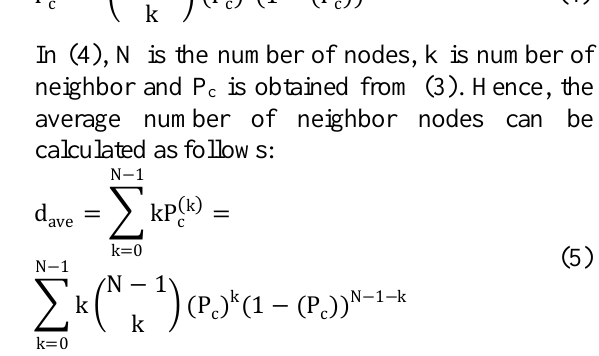
Figure 2. Flowchart of PSO